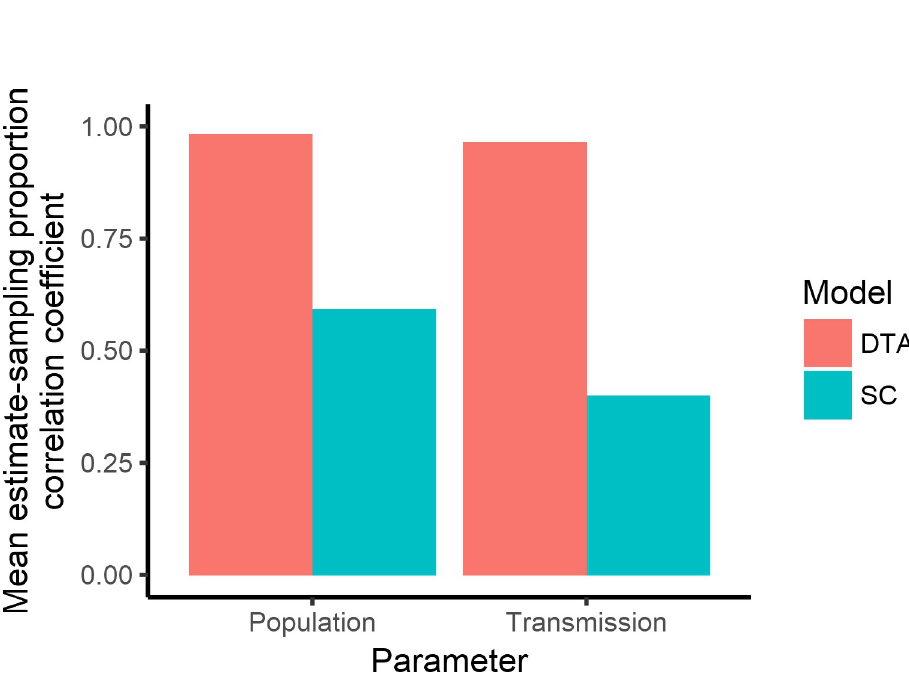
Fig 4. Bar graph of the correlation coefficients between the models’ mean estimates and the proportion of sampled isolates that are animal or human hosts for the same outbreak that was disproportionately sampled.